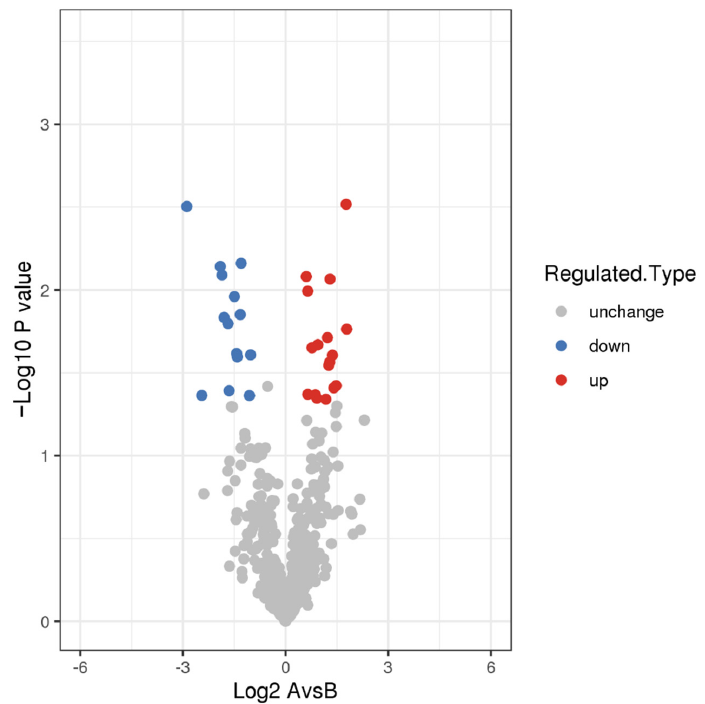
Figure 1. Volcano plot of DEPs. The blue dots represent proteins that are up-regulated (infection group vs. healthy group). The red dots represent down-regulated proteins (infection group vs. healthy group).